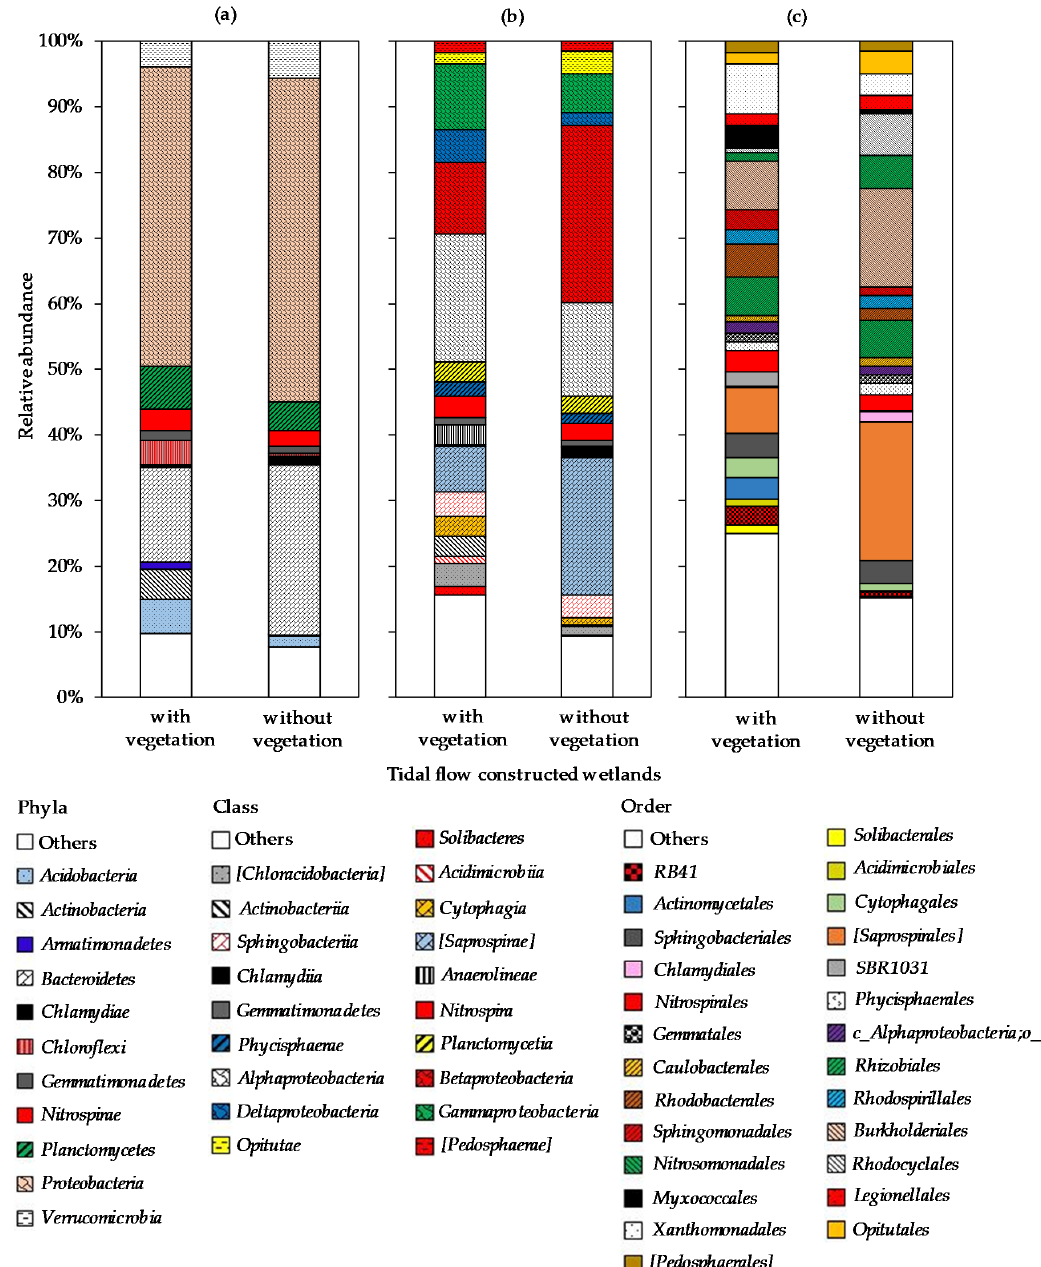
Figure 7. Bacterial community compositions at the ( a ) phylum, ( b ) class, and ( c ) order level in the tidal flow CWs with and without vegetation (common reed plants) on the last day (60th day) of operation.